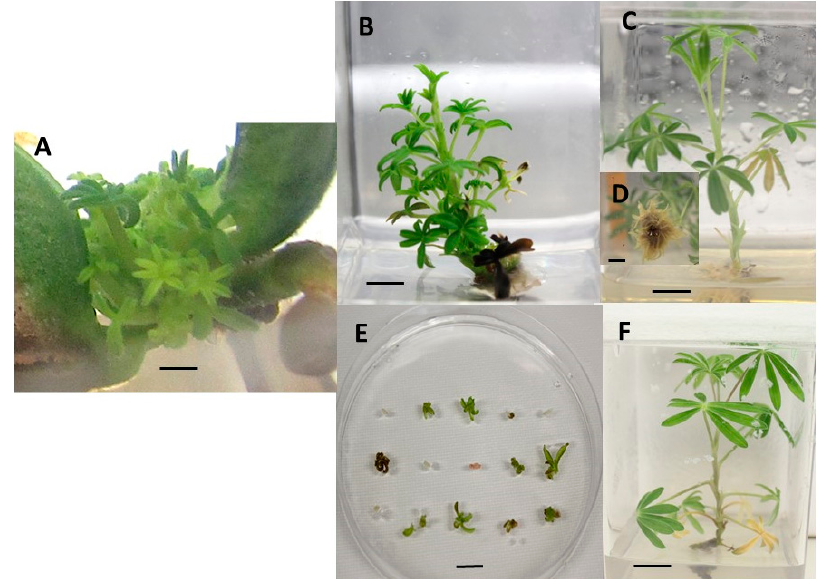
Figure 2. In vitro culture of seeds, plants and cryopreserved shoot tips of Lupinus rivularis . Multiple shoot induction from seeds on medium with 10 µM TDZ ( A ); In vitro plant developed from basal explant on medium with 5 µM BA ( B ); Rooting of individual shoots subcultured on the medium with 20 µM IBA ( C , D ); Survival of cryopreserved shoot tips, 30 days after cryopreservation ( E ); Plant regeneration from cryopreserved shoot tips, 6 months after cryopreservation ( F ). Bar in A–F = 1 cm.